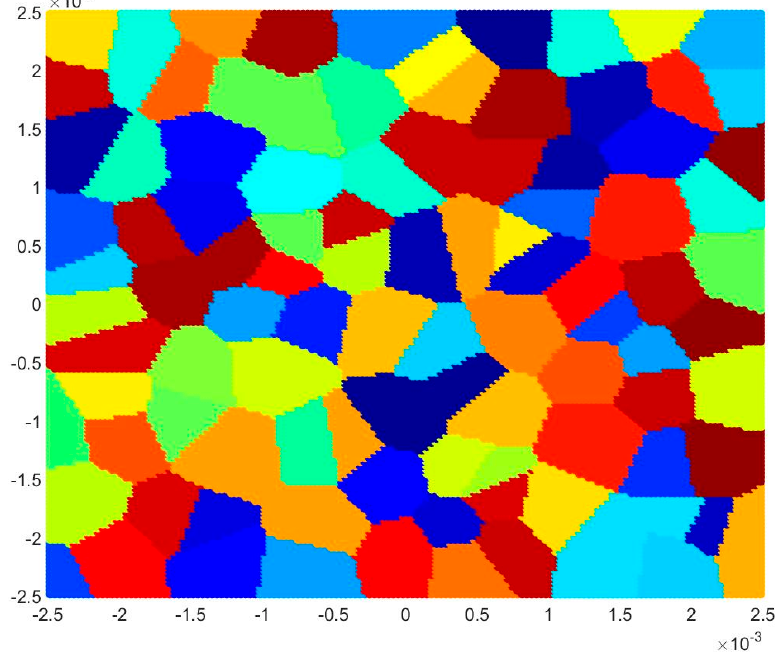
Figure 12. Polycrystal model for dynamic analysis (100 grains).